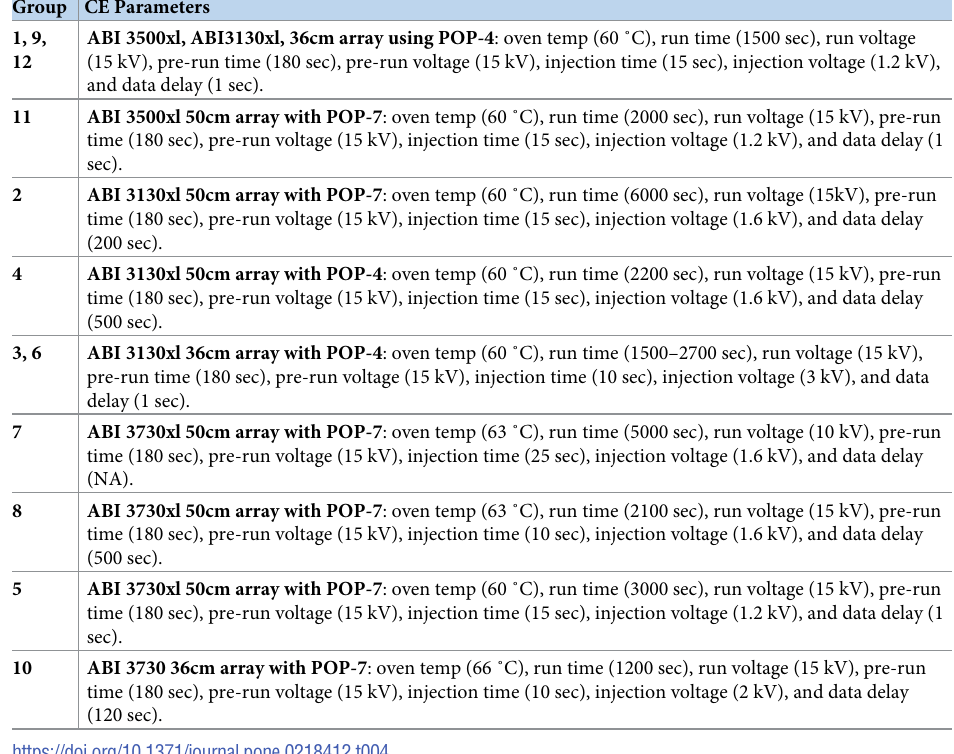
Table 4. Parameters for capillary electrophoresis for each